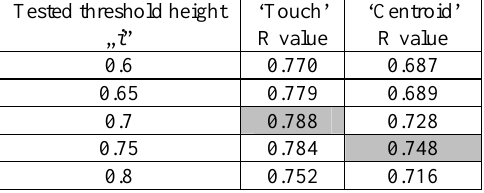
Table 2. ALS data characteristics